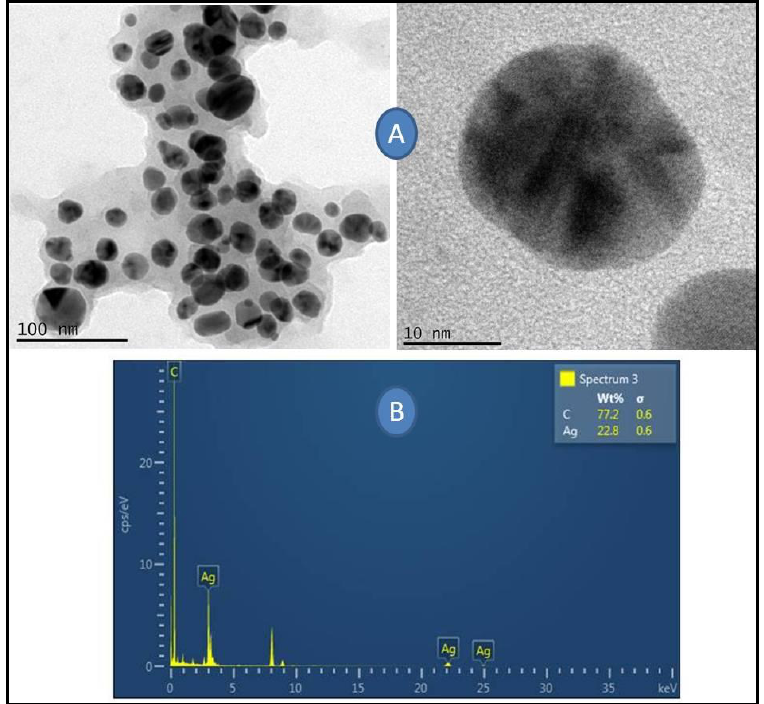
Figure 3. ( A ) and ( B ). TEM and EDX analysis of biogenic AgNPs. ( A ) AgNPs size determination using TEM analysis; ( B ) silver peaks were observed in the EDX of AgNPs.